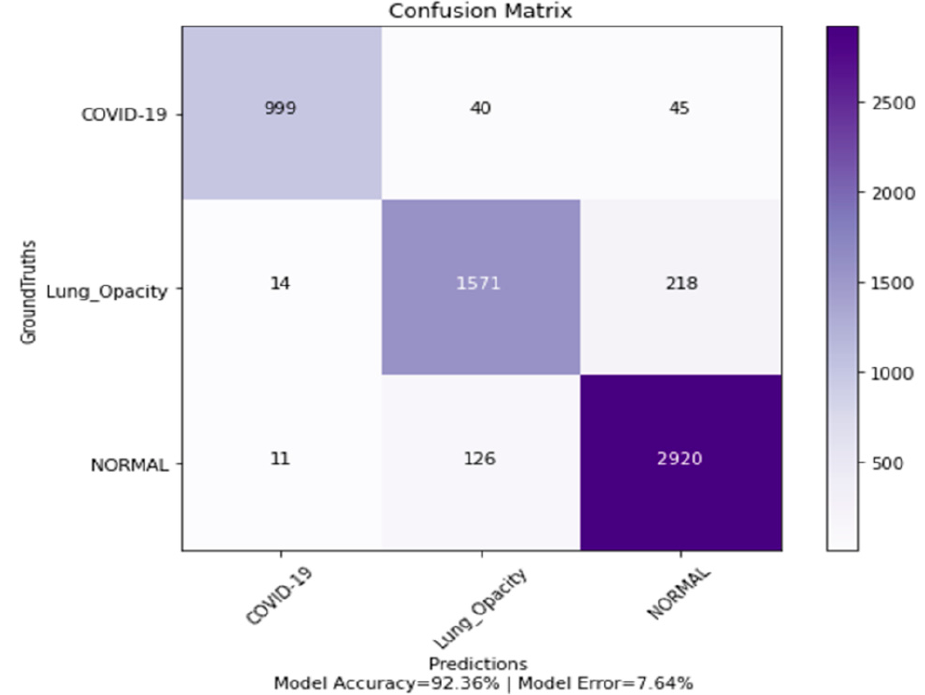
Figure 11. Confusion matrix for Custom-Model.